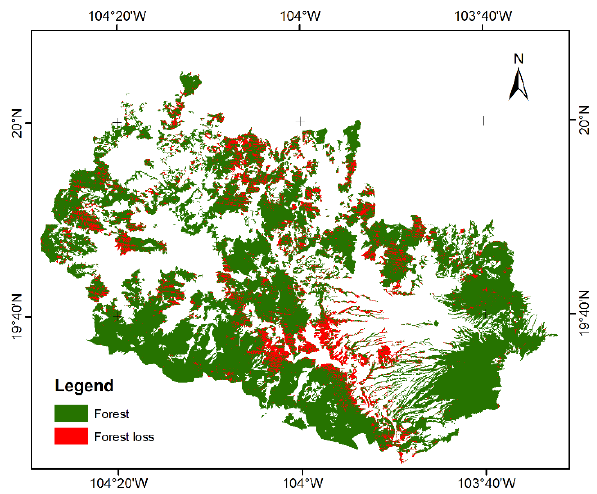
Figure 3. The detected forest loss by applying the threshold of magnitude of change (-0.2).